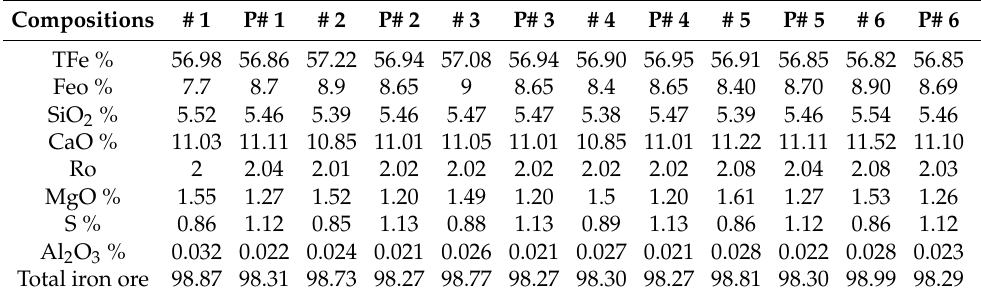
Table 2. Comparison of the actual composition and the predicted composition using our SCORN model (# means the actual number, and P# represents the predicted